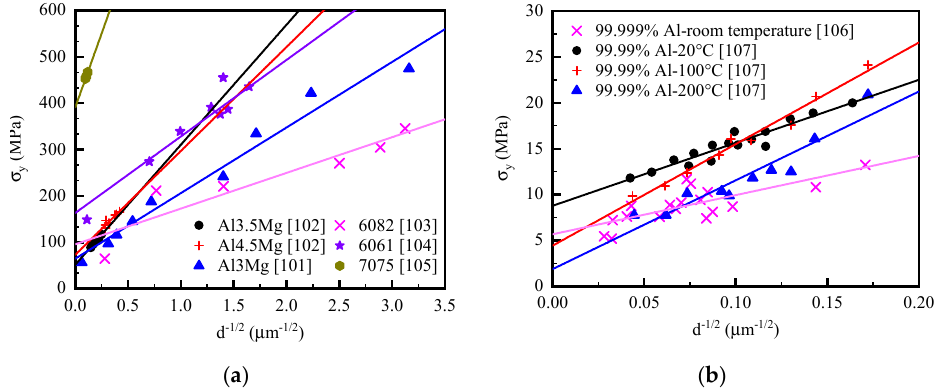
Figure 13. Relationship between yield strength ( 𝜎 (cid:3052) ) and d − 1/2 for ( a ) Al alloys at room temperature [101–105] and ( b ) pure Al at different temperatures [106,107]. Here d is the average grain size.